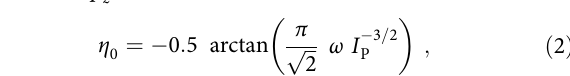
acquired by the propagation in the laser fi eld the momentum p from L C denotes the angle of maximal I